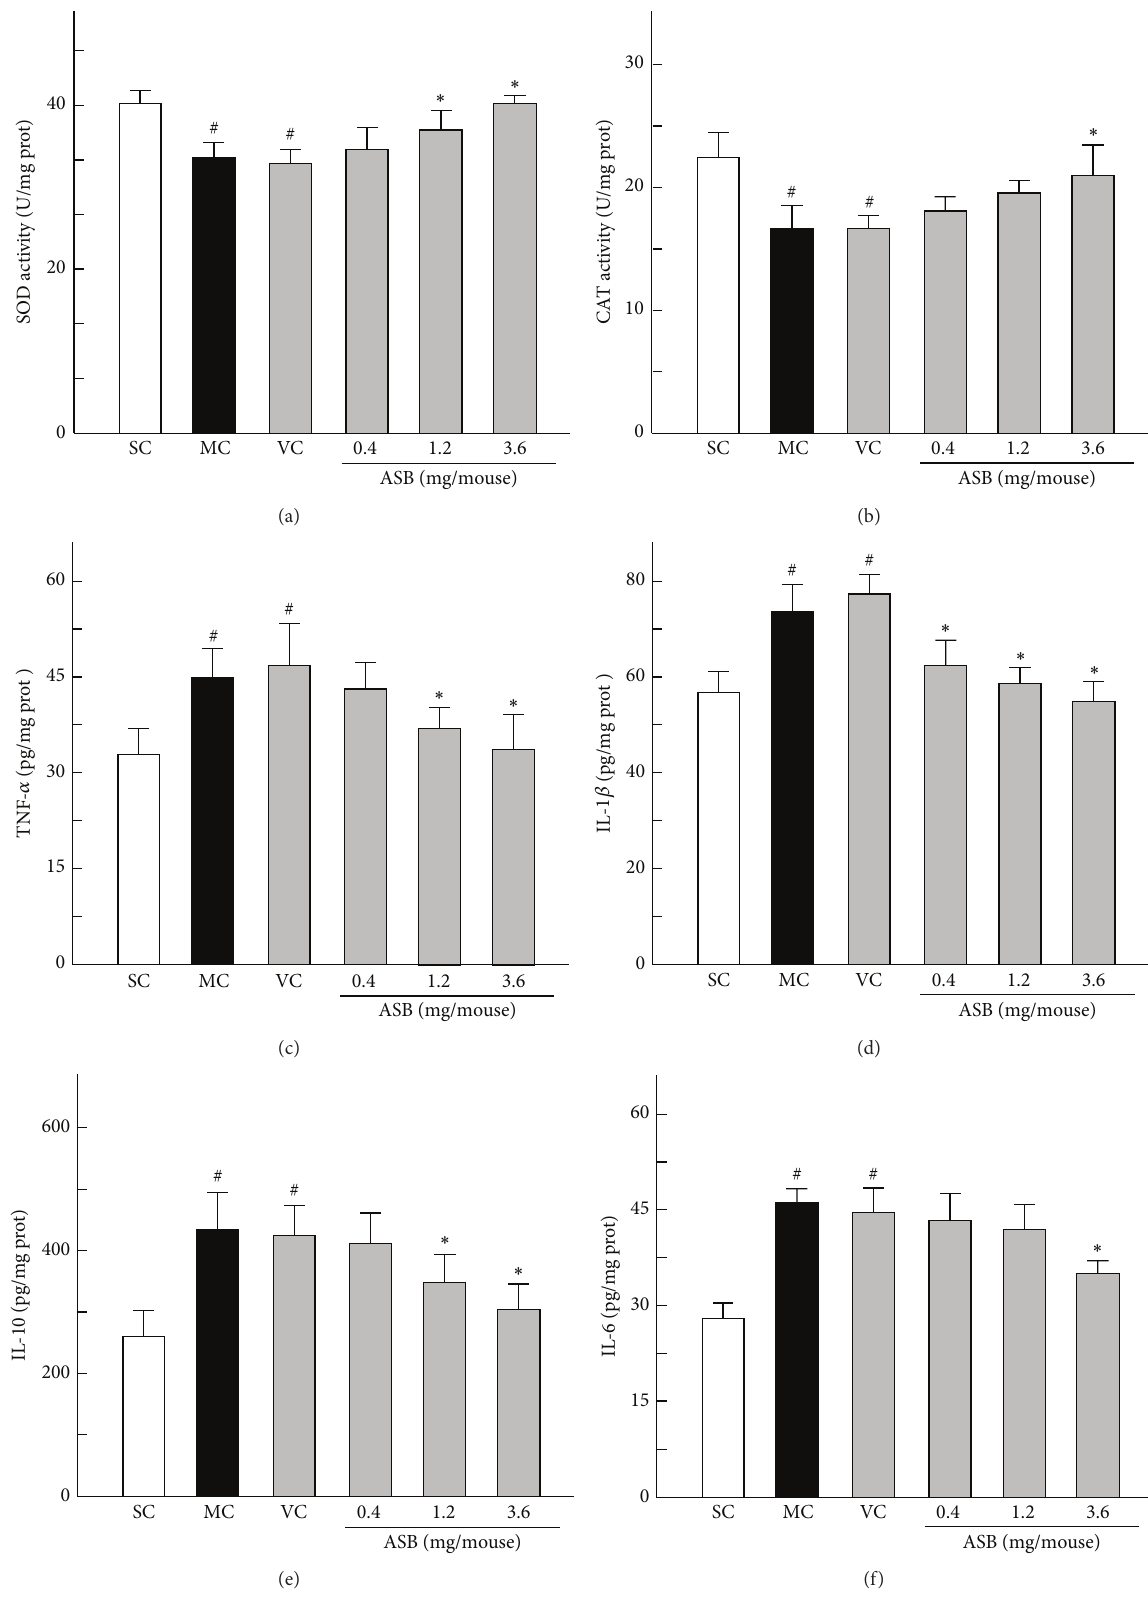
Figure 4: Effect of andrographolide sodium bisulfate (ASB) on the activities of antioxidant enzymes and the expression of inflammation cytokines in photoaged mice skin. Data represents means ± SD ( 𝑛 = 8 ). # 𝑝 < 0.05 compared with the SC group; ∗ 𝑝 < 0.05 compared with the VC group. NC, normal control; SC, sham control; MC, model control; VC, vehicle